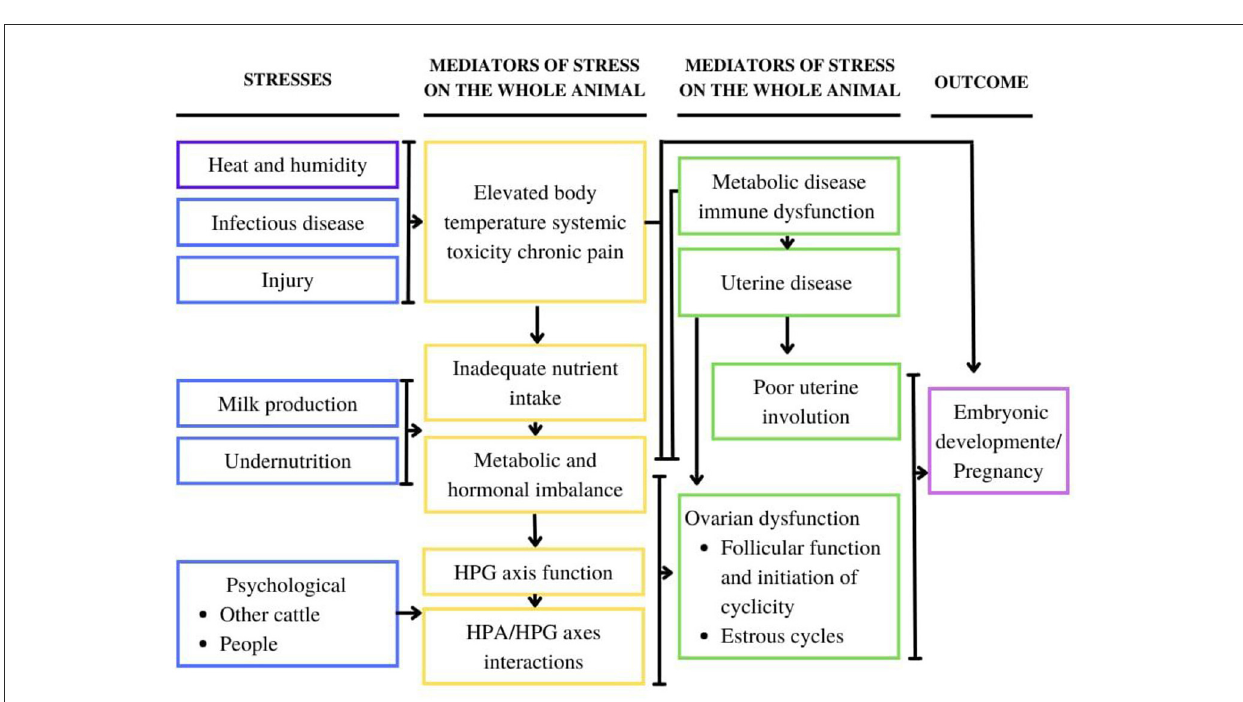
FIGURE7 Schematic drawing on the main aspects that affect cattle, as well as the mediators of stress in the animal, and finally the associated strain that affects the pregnancy outcome. HPG, hypothalamic-pituitary-gonadal; HPA, hypothalamic-pituitary-adrenal. Adapted from Matthew (52).